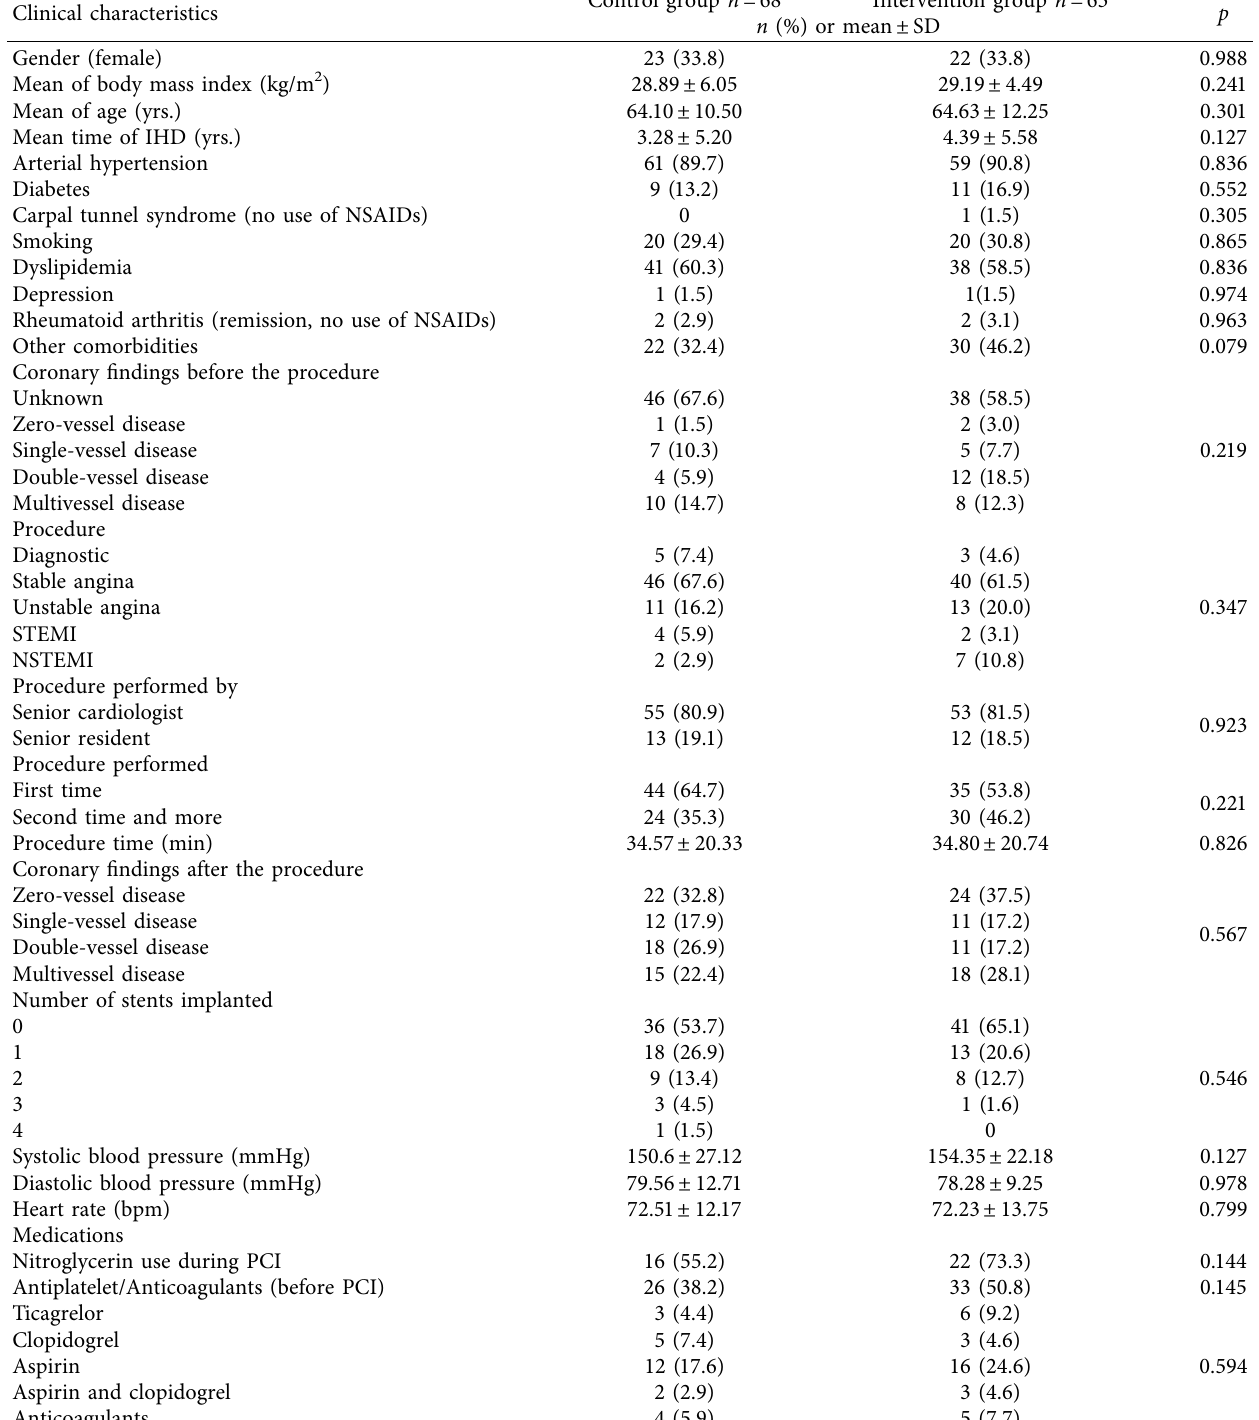
Table 1: Patients demographic and clinical characteristics of control and intervention